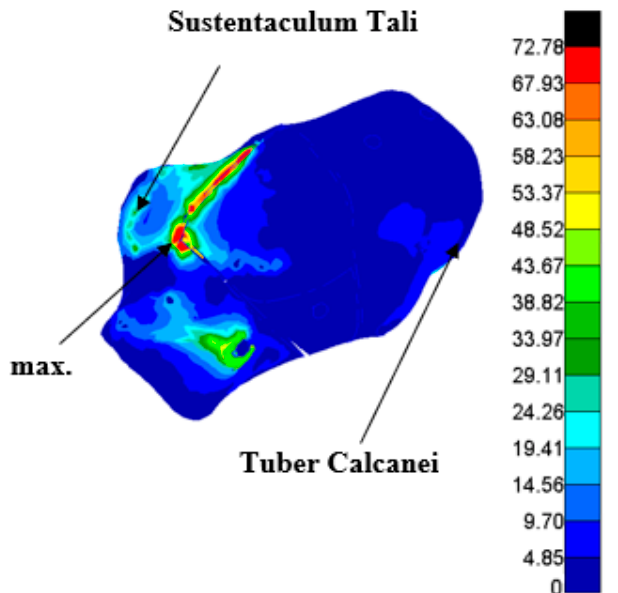
Figure 18. Distribution of the reduced stress on the fractured heel bone containing C-NAIL according to the HMH theory/MPa/.